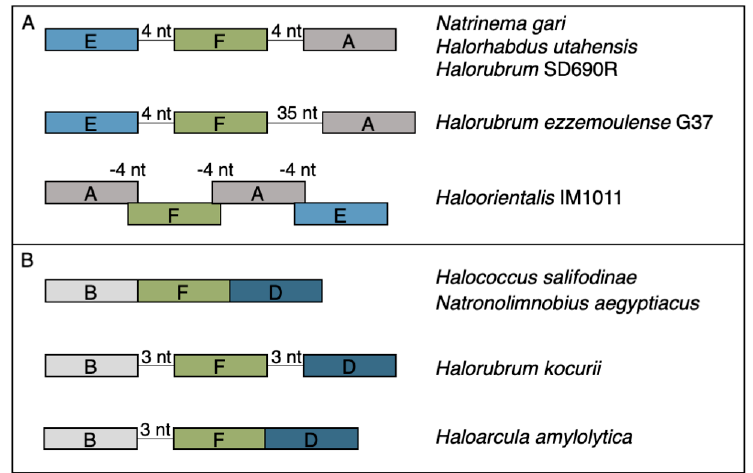
Figure 3. Gene maps for syntenic clusters of gene families ( A ) EFA and ( B ) BFD found in a subset of organisms identified to the right of each map. Genes are colored by gene families with Type I methylases (families A and B) in grays, Type I restriction endonucleases (DE) in blues, and Type I site specificity unit (F) in green.